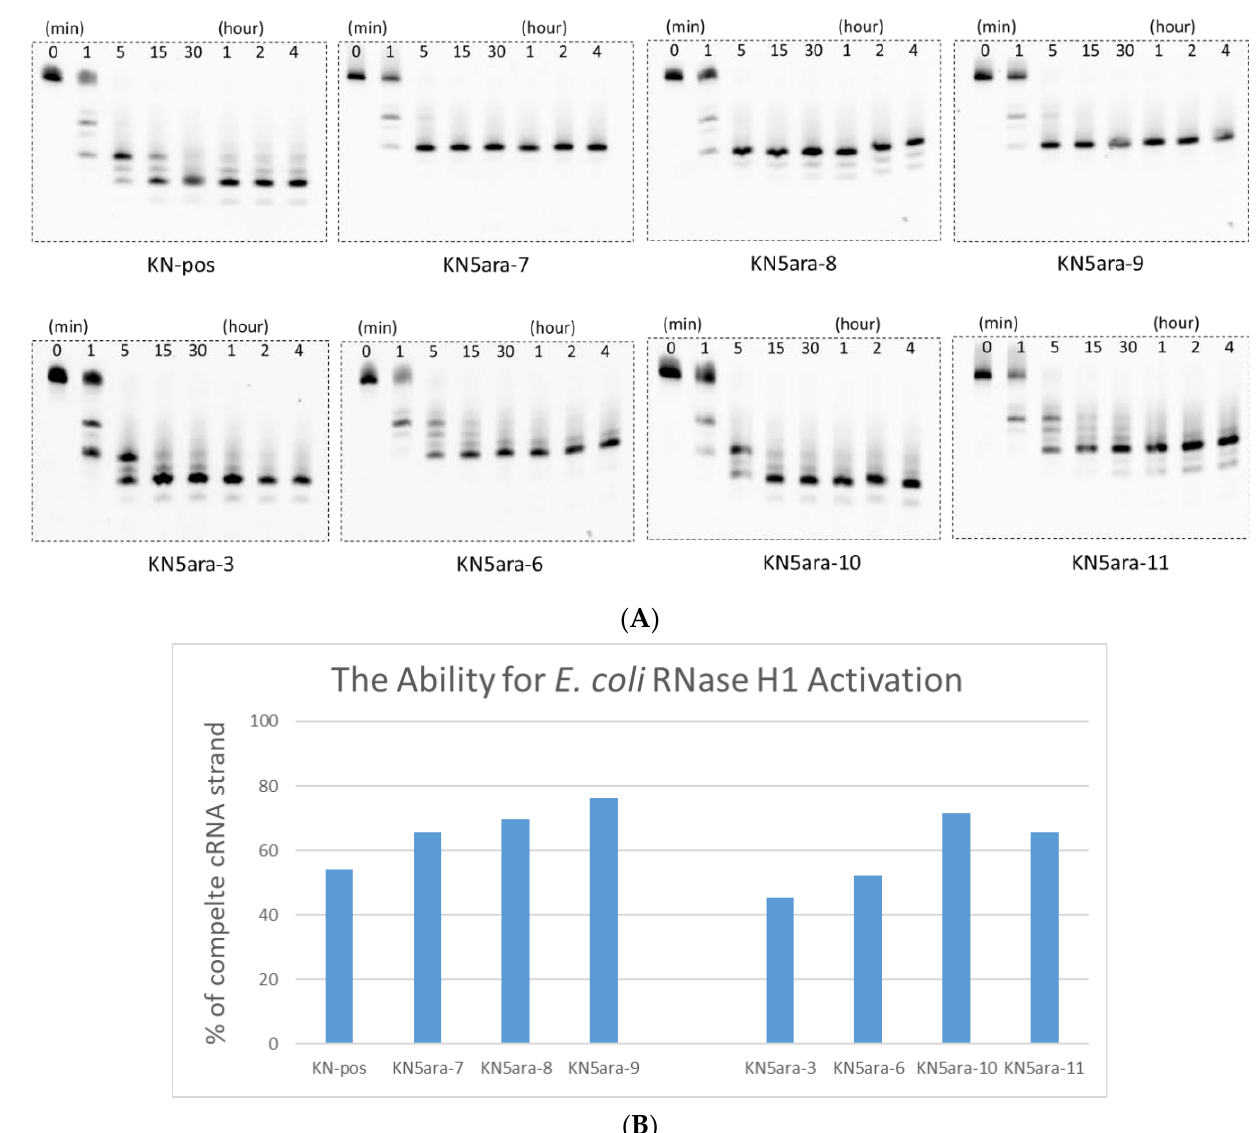
Figure 2. PAGE analysis of ASO/RNA duplexes treated in a buffer containing 50 mM Tris–HCl (pH 8.0), 75 mM KCl, 3 mM MgCl 2 , 10 mM dithiothreitol, and RNase H1 from E. coli. Sequence of complementary RNA strand (cRNA-2) is shown in Table S1. All duplexes were incubated in a buffer containing 50 mM Tris–HCl (pH 8.0), 75 mM KCl, 3 mM MgCl 2 , and 10 mM dithiothreitol, and then diluted RNase H1 solution (60 unit/L in H 2 O) was added; subsequently, the mixture was incubated at 37 ◦ C for the required time. The reaction mixtures at various incubation times (0, 1, 5, 15,